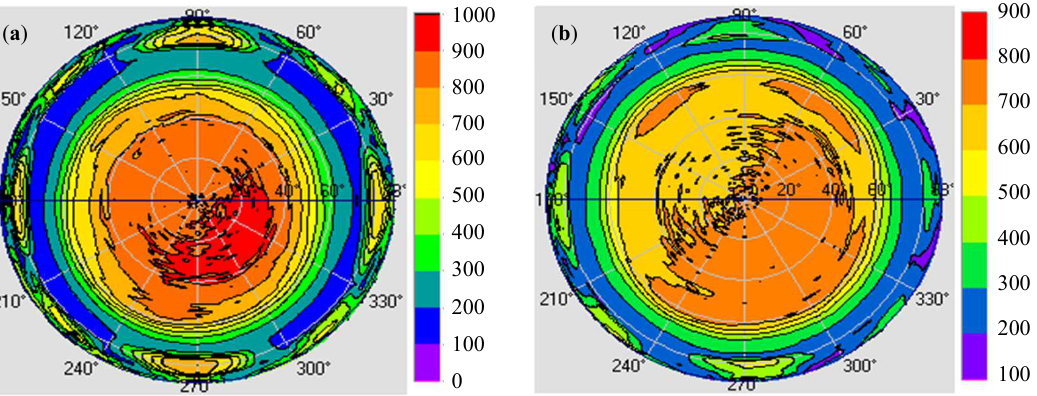
Figure 12. Simulation of the light guide layer unit module with a diffusion film: ( a ) without concave PSMLAs; ( b ) with concave PSMLAs.